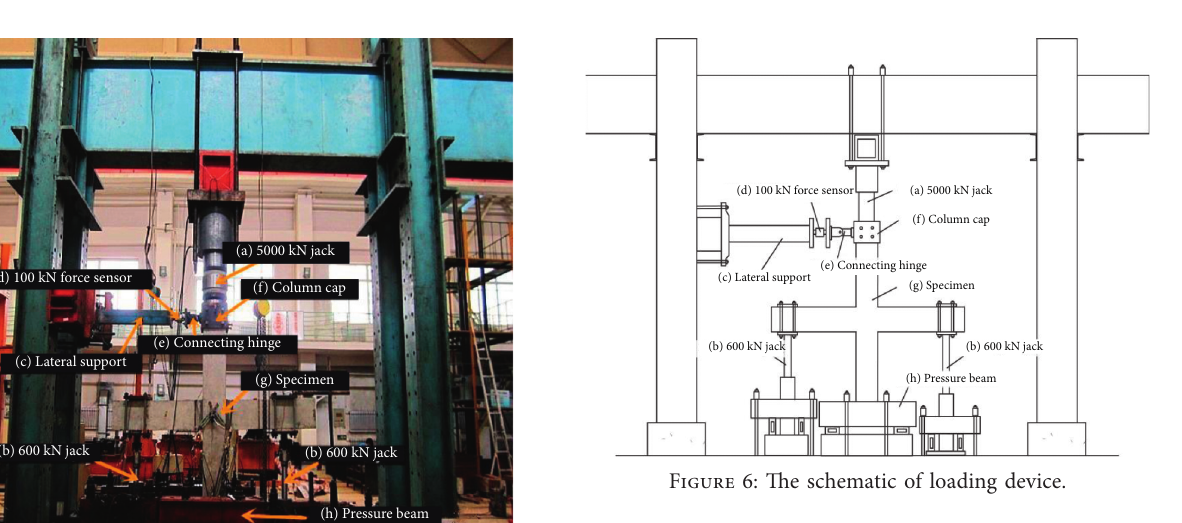
Figure 4: Arrangement of displacement meters and strain gauges. (a) Displacement meters. (b) Strain gauges of stirrup. (c) Concrete strain gauges.